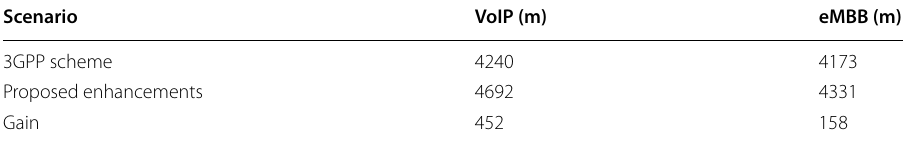
Table 11 Comparison of achievable cell coverage with the 3GPP scheme and proposed